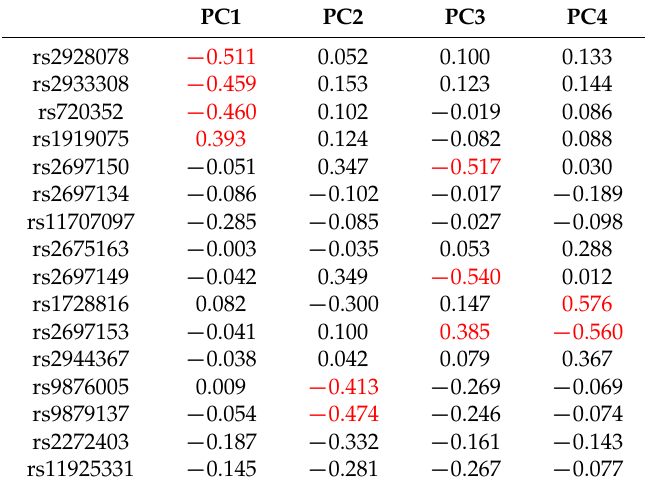
Table 4. Loading of each SNP on the first four principal components used in the gene-level analysis. PC1